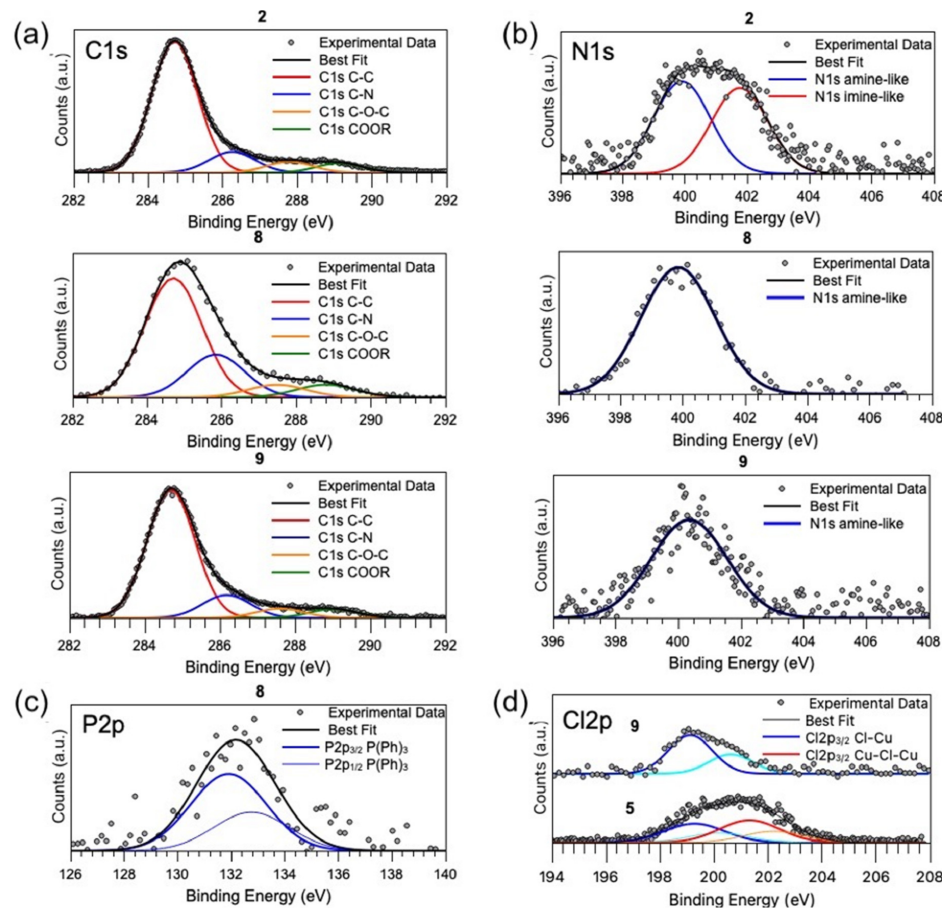
Figure 3. ( a ) C1s XPS spectra of 2 (top), 8 (middle), and 9 (bottom); ( b ) N1s XPS spectra of 2 (top), 8 (middle), and 9 (bottom); ( c ) P2p spectrum of complex 8 ; ( d ) Cl2p spectra of 9 (top) and 5